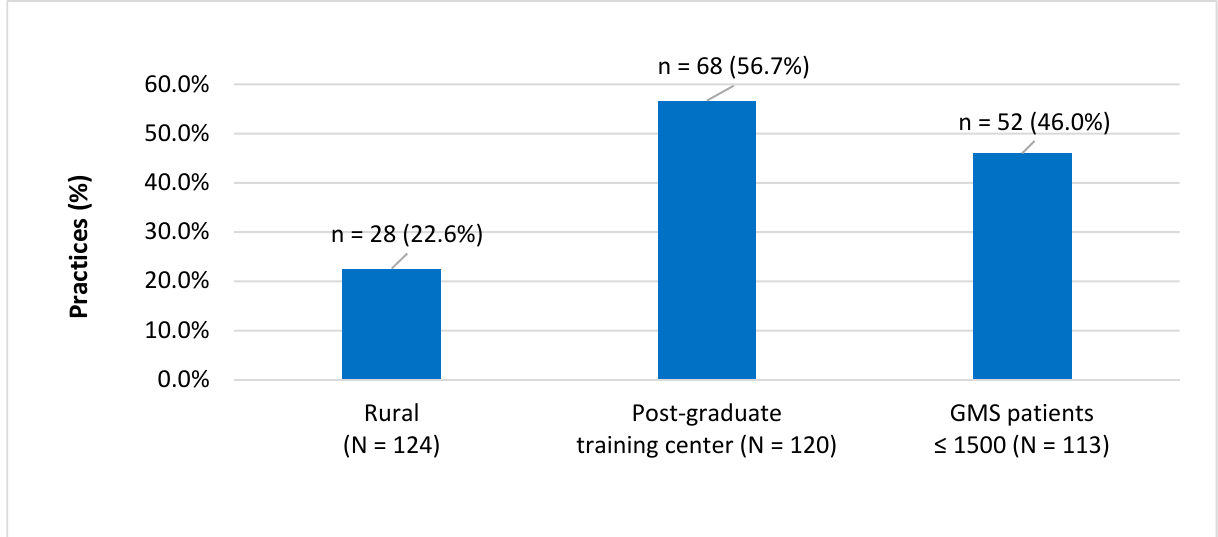
Figure 1. Characteristics of practice by location, training, and GMS patients’ size.